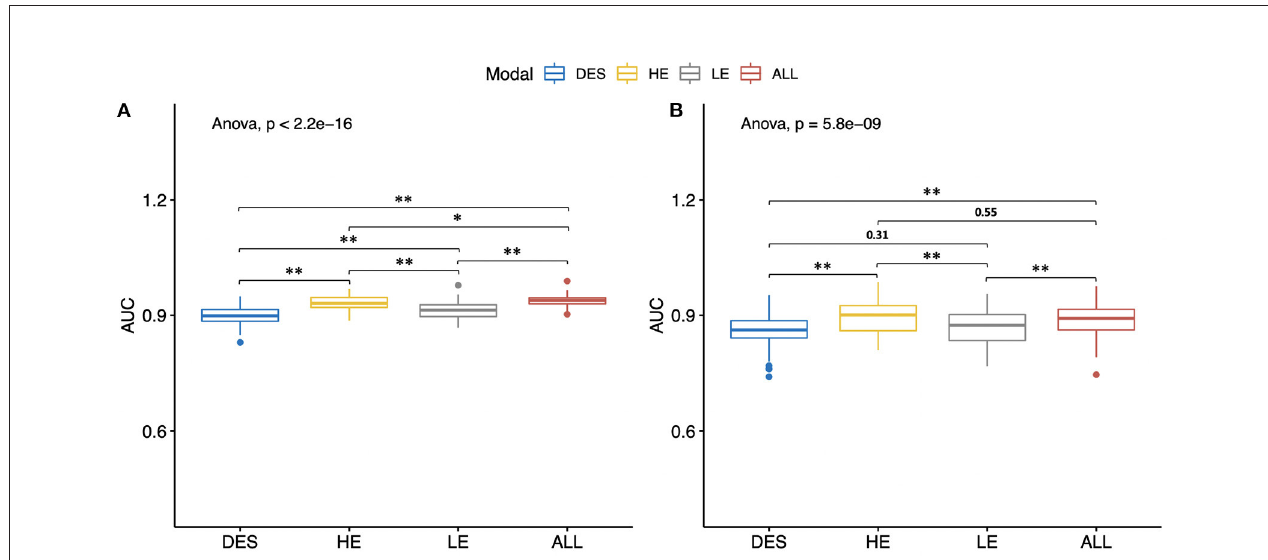
FIGURE 7 | Mean values of the areas under the receiver operating characteristic curves (AUCs) of different types of contrast-enhanced mammography images. All of the models were constructed by the radiomic features of both craniocaudal and mediolateral oblique views. The Wilcoxon rank-sum test and the Kruskal–Wallis rank-sum test were used to compare the mean AUC values of different models. The false discovery rate correction was performed for multiple comparison. (A) Mean AUCs in the training set. (B) Mean AUCs in the testing set. HE, high-energy; LE, low-energy; DES, dual-energy subtraction; “ALL” stands for a combination of HE, LE, and DES images. * P < 0.05. ** P <